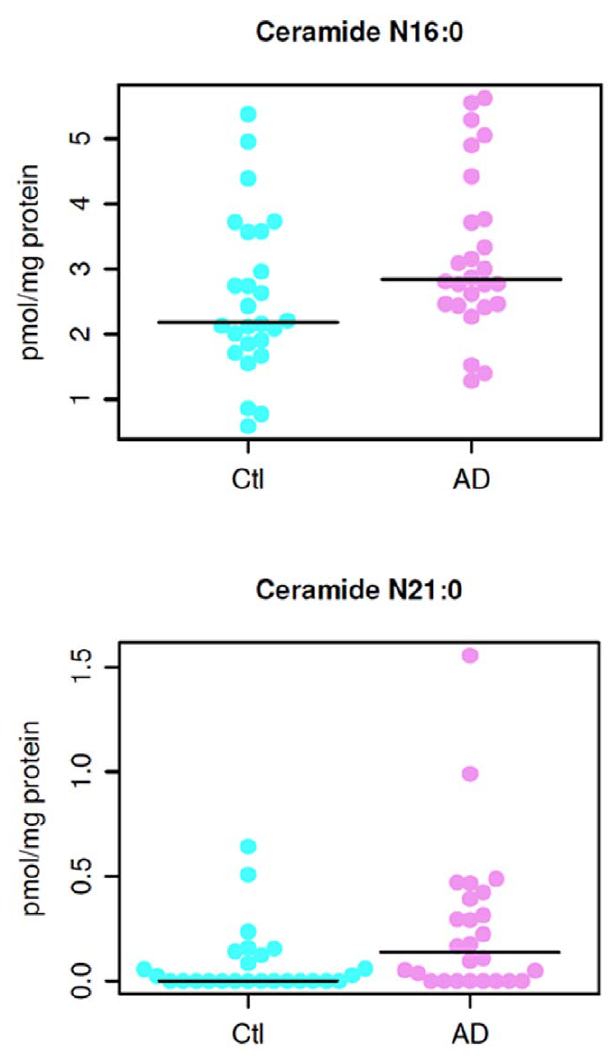
Figure 4. Mass levels of N16:0 (panel A) and N21:0 (panel B) ceramide species in AD and healthy controls.